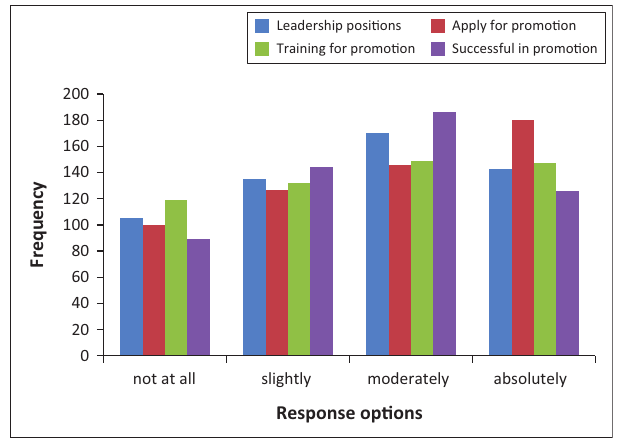
FIG URE 3: The extent to which the EEA is implemented in a facility. TABLE 5: Statistical significant differences as they relate to Question 3. Question 3: Indicate the extent to which you think the EEA is implemented in the facility where you are